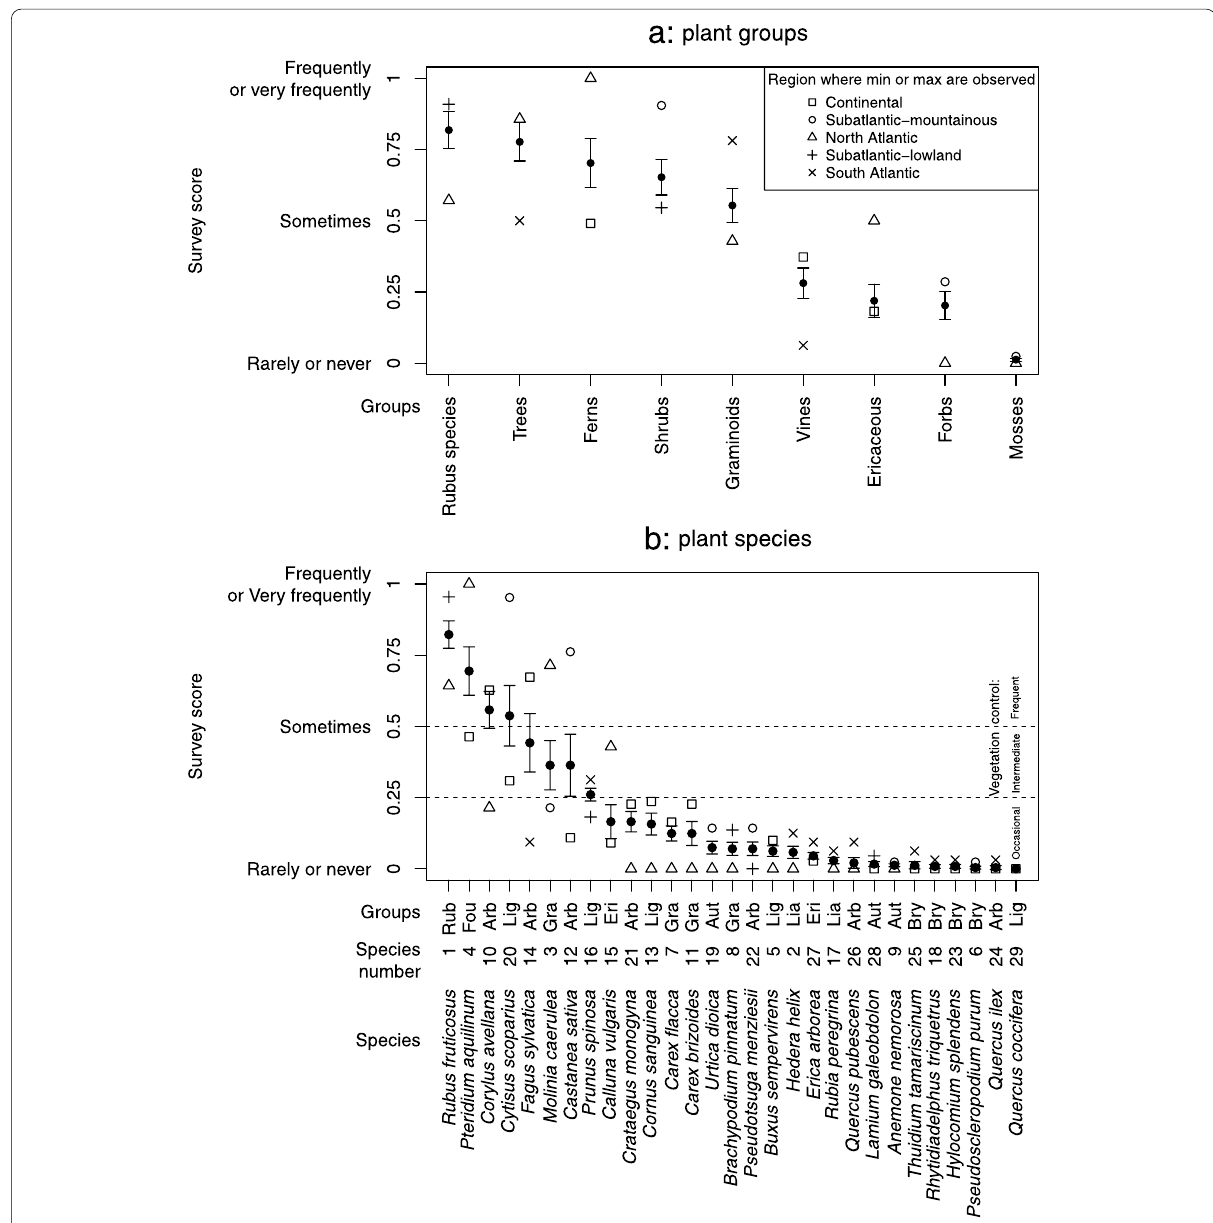
Fig. 3 Intervention scores for a the nine plant groups and b the 29 plant species across the five study regions (mean, standard error, maximum, and minimum value) computed from the forest manager survey. The point type used for the minimum and the maximum values for each group or species indicates the region where the value is observed. Groups and species were ranked by decreasing average frequency of intervention. In b , dashed horizontal lines correspond to the thresholds, y 0.25 and y 0.5, used in the three sets of conditions that define species requiring = = frequent, intermediate, and occasional vegetation control according to forest managers. “Groups” correspond to the plant group to which each species belongs and “species numbers” to the number assigned to each species and given in Appendix Table